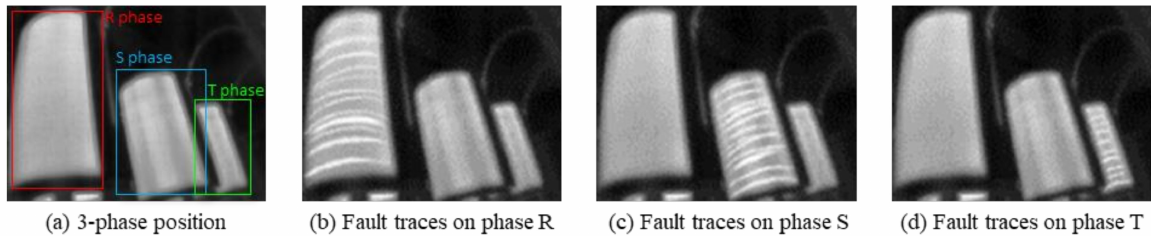
Figure 12. The position of the three-phase ITSC.